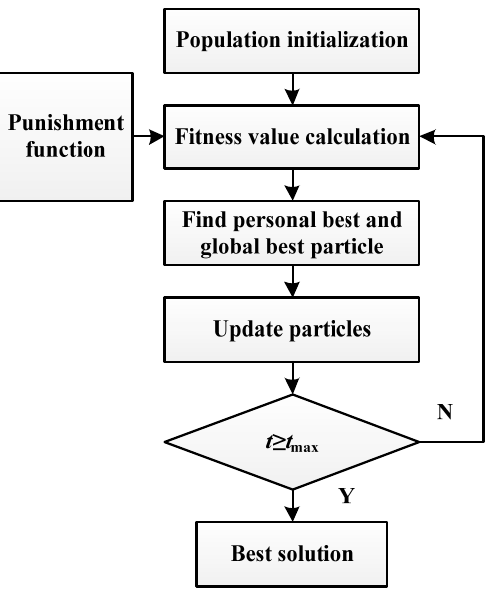
Figure 1. Flow chart of FDPSO.